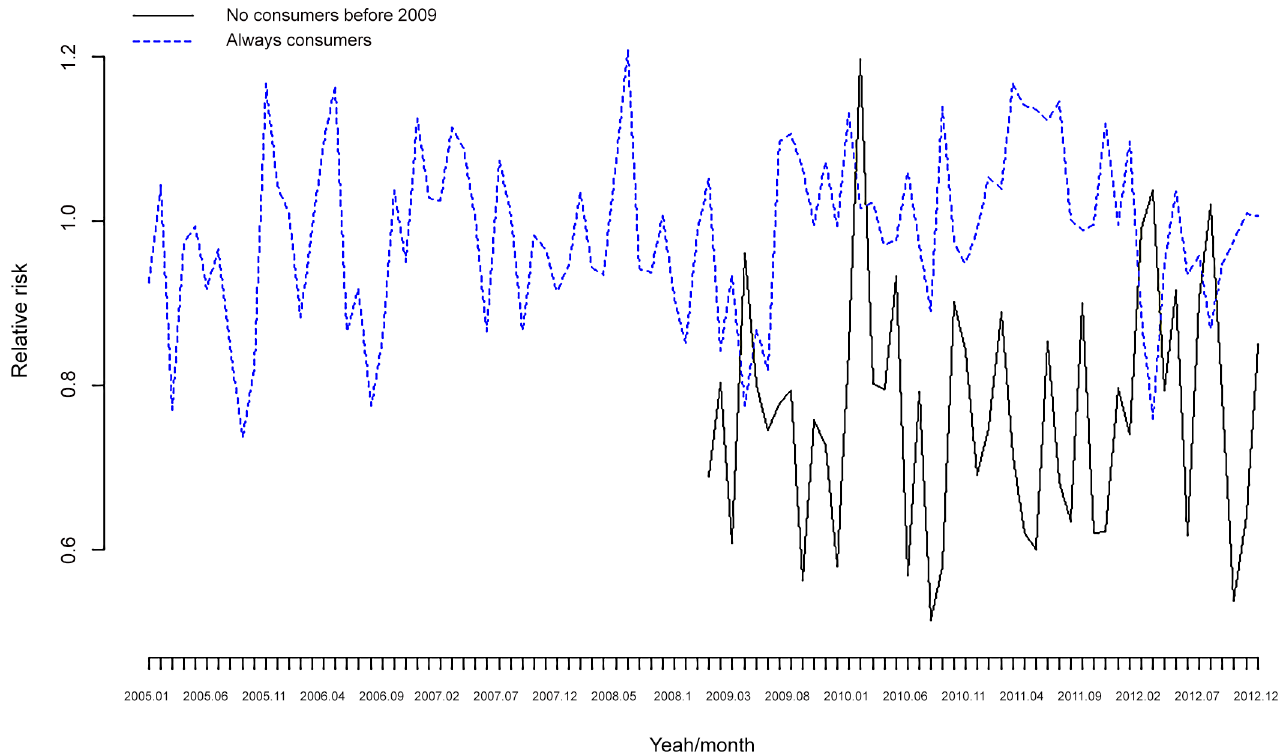
Fig 8. DDD per individual/month. Not consumers before 2009 vs. Always